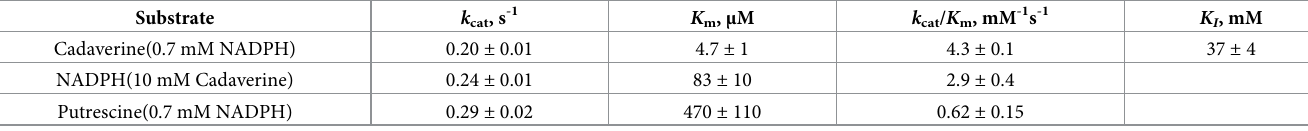
Initial rates measured with varied concentrations of cadaverine or putrescine (or 10 mM) in the presence of Ss DesB, 50 μ M FAD, and 0.7 mM NADPH (or varied concentrations). All measurements were made in